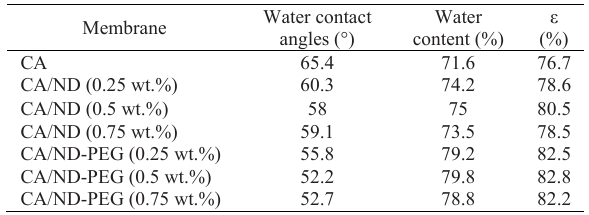
Table 2. Contact angle, porosity and water content of fabricated membranes.